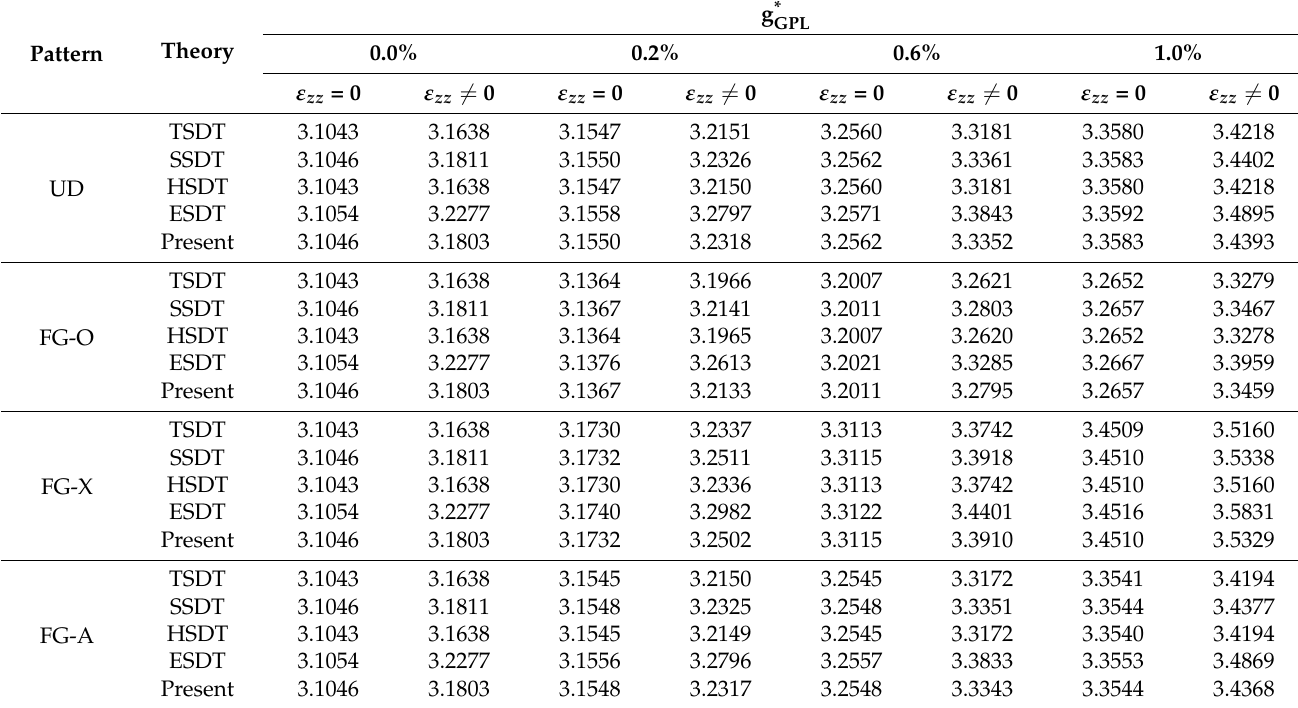
Table 5. Dimensionless critical buckling load of GRC plate subjected to a compressive uniaxial in-plane loading influenced by weight fraction g ∗ GPL